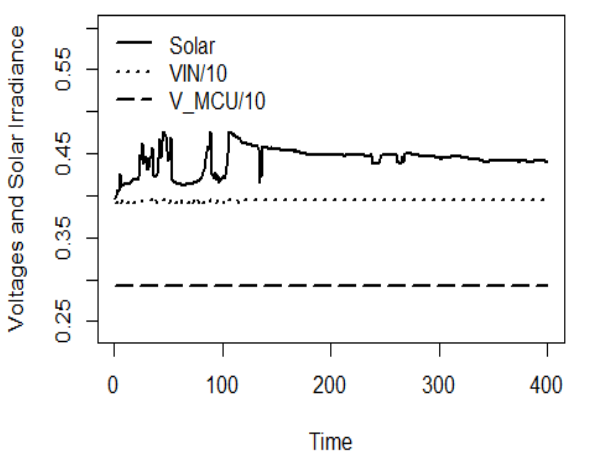
Figure 3 . Input voltage, MCU voltage and Solar